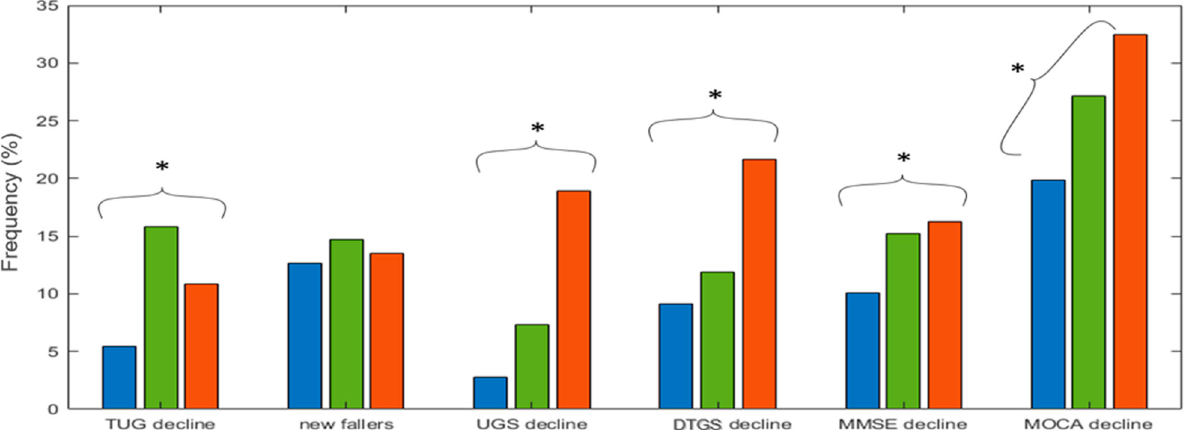
Figure 10. Percentage of TUG decline, new fallers, UGS decline, DTGS decline, MMSE decline and MOCA decline across clusters. The bars are coloured based on the corresponding cluster (blue, green and red, respectively). Stars indicate whether the condition of decline of a given participant statistically significantly depended on the classification in clusters, namely if the classification in clusters statistically significantly represented a difference in percentage of